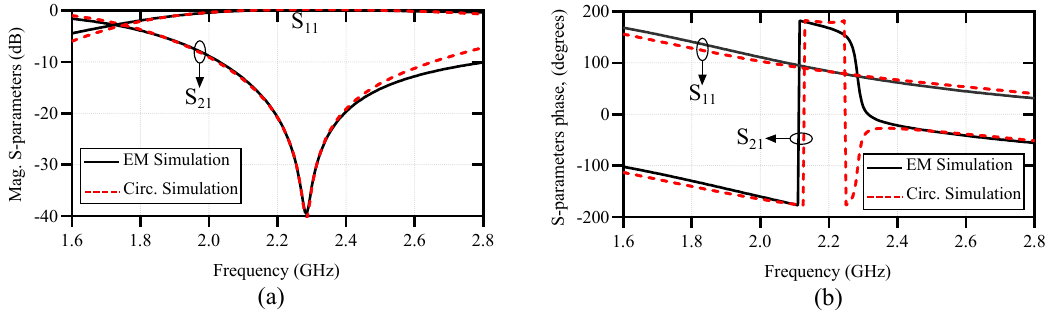
Figure 3. Comparison between the full-wave electromagnetic and the circuit model simulation results of a microstrip line loaded with MLC resonator, when the electric wall of the resonator is aligned with the magnetic wall of the microstrip transmission line. ( a ) Amplitude response and ( b ) phase response. The extracted lumped element values are L = 4.7 nH, C = 1.162 pF, C R = 1.94 pF, and L R = 1.566